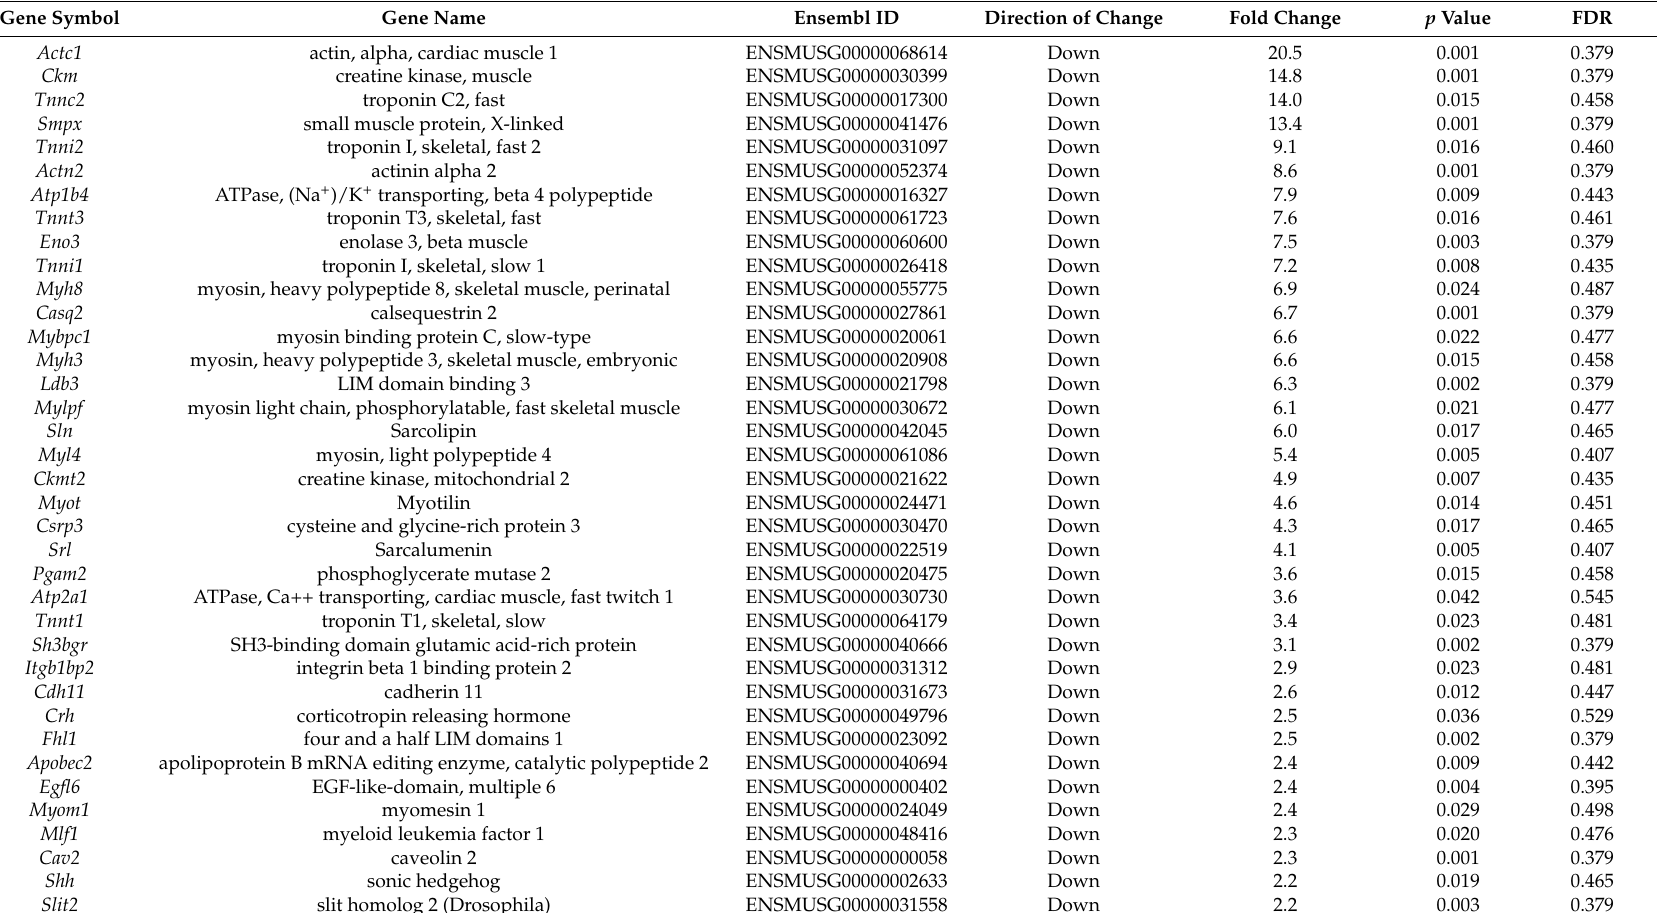
Table 1. Genes with greater than two-fold expression change in fetal liver in response to maternal folate depletion 1,2